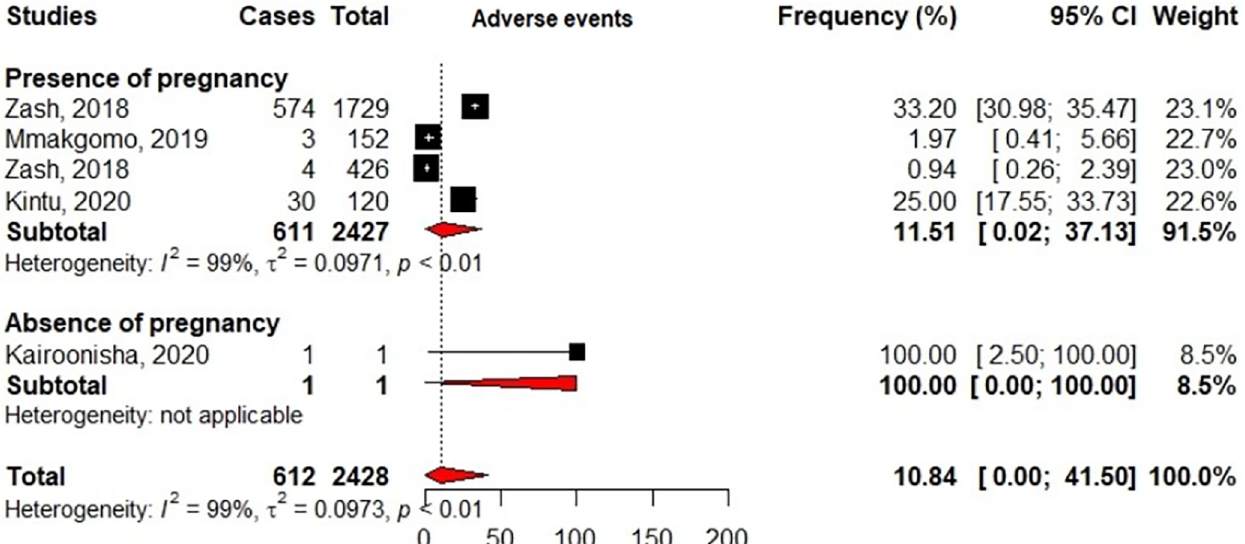
Fig 6. The plot was constructed with R v3.6.0 software, with the use of “meta” and “metaphor” packages. Weights are all from random effects analyses and represent the degree of confidence of each study compared to all other studies in the meta-analysis. Squares represent the prevalence of adverse events in each study, with plain lines representing 95%CI in those studies. Diamonds represent pooled estimates within subgroups, with the value being at the center while extremities play the role of 95%CI. The interrupted line represents the median value after aggregation of all the data while the 0–40 scale represents the range of possible data in the